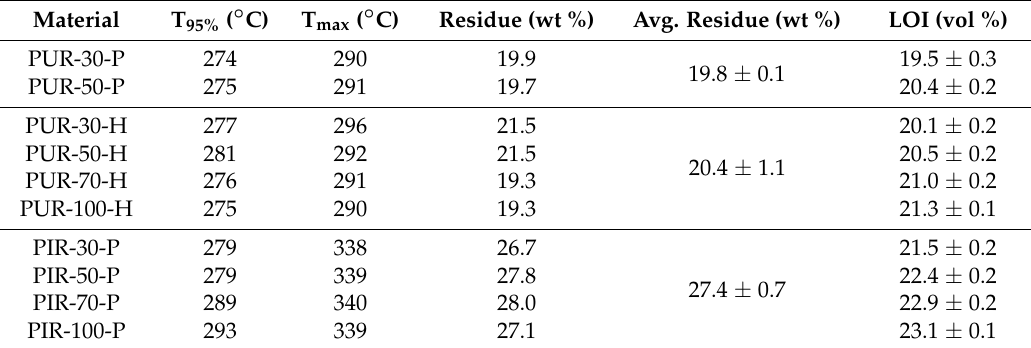
Table 3. Results of TG and LOI